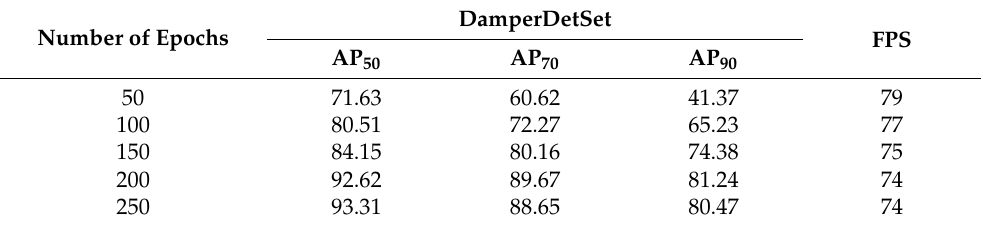
Table 6. APs of different epoch numbers.